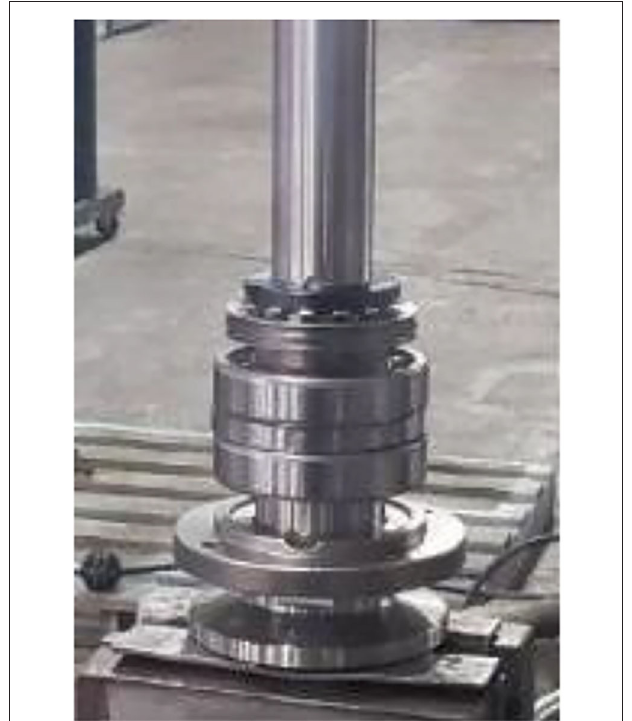
FIGURE 12 | Assembled